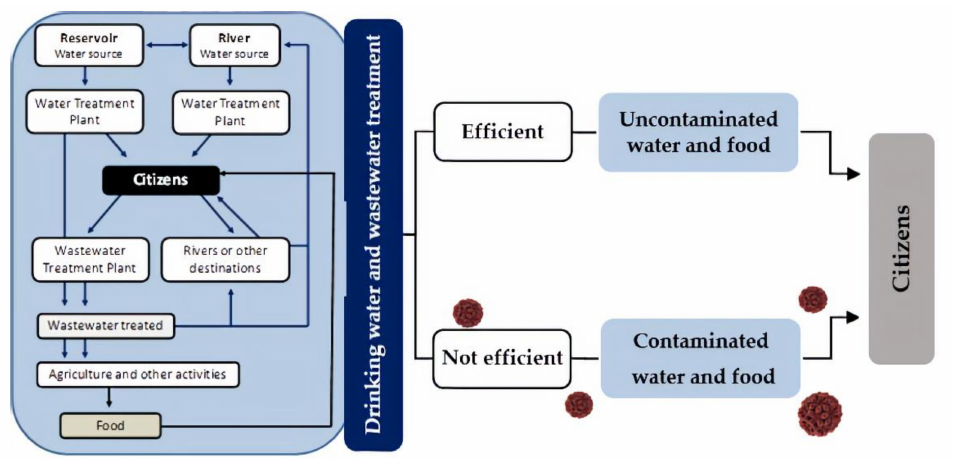
Figure 1. Schematic representation of water collection and distribution networks and their influence on human